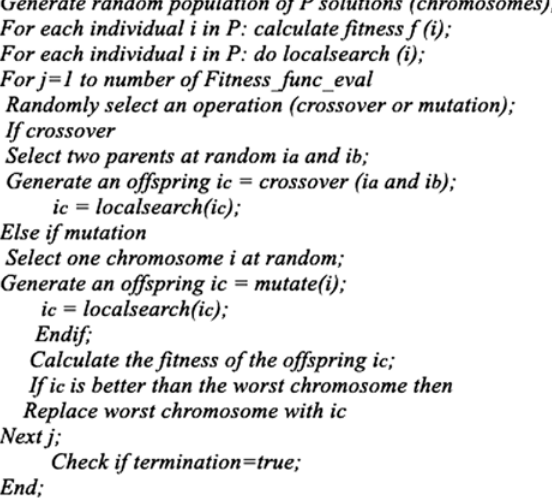
Figure 1: Pseudo-code for MA.